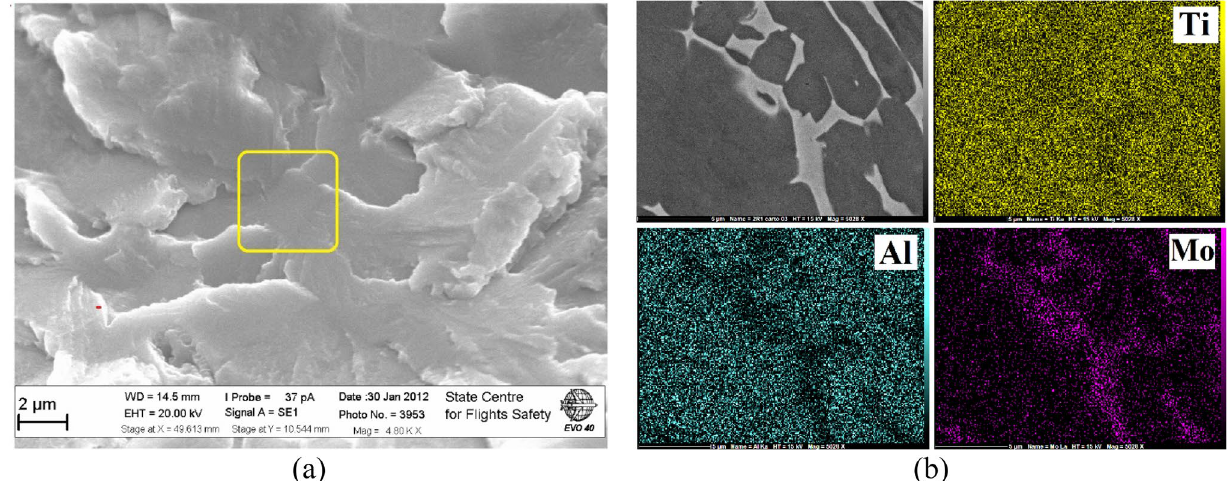
Fig. 10 Area of fatigue crack nucleation during formation of a hearth under the surface in the form of a smooth facet ( a ) and an example of chemical elements mapping in a similar area ( b